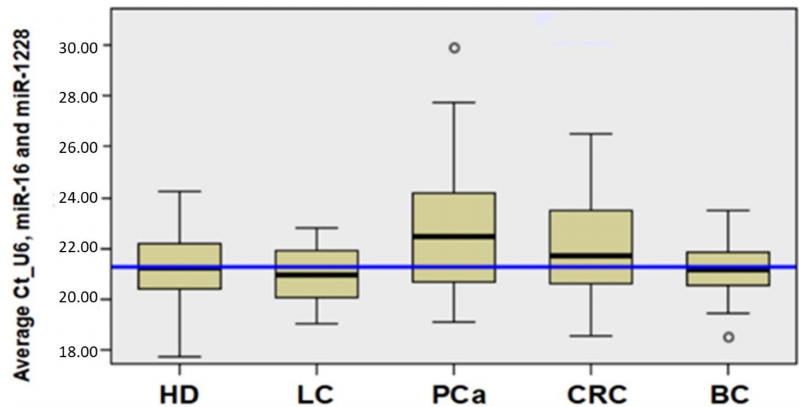
Figure 1. Selection of housekeeping genes: According to the null hypothesis, the median value of Ct of housekeeping genes has nonsignificant di ff erences ( p = 0.165), and the mean of Ct of U6snRNA, miR-16, and miR-1228 was used as a reference. Test used: nonparametric test for independent samples. The median value for each group is defined by the bold, black line within the box.